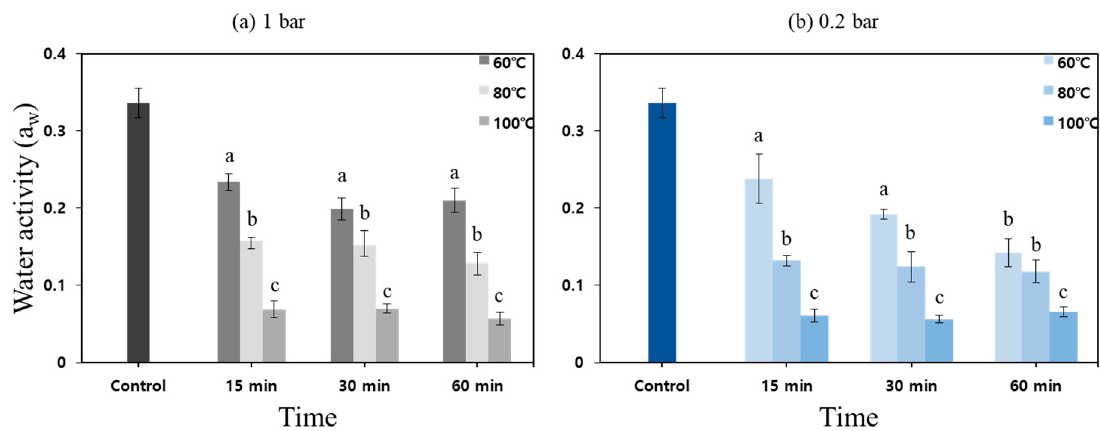
Figure 10. The inactivation of E. coli O157: H7 in sprout barely powder treated by different heating condition: ( a ) 1 bar, ( b ) 0.2 bar. Different letters indicate significant differences ( p < 0.05).